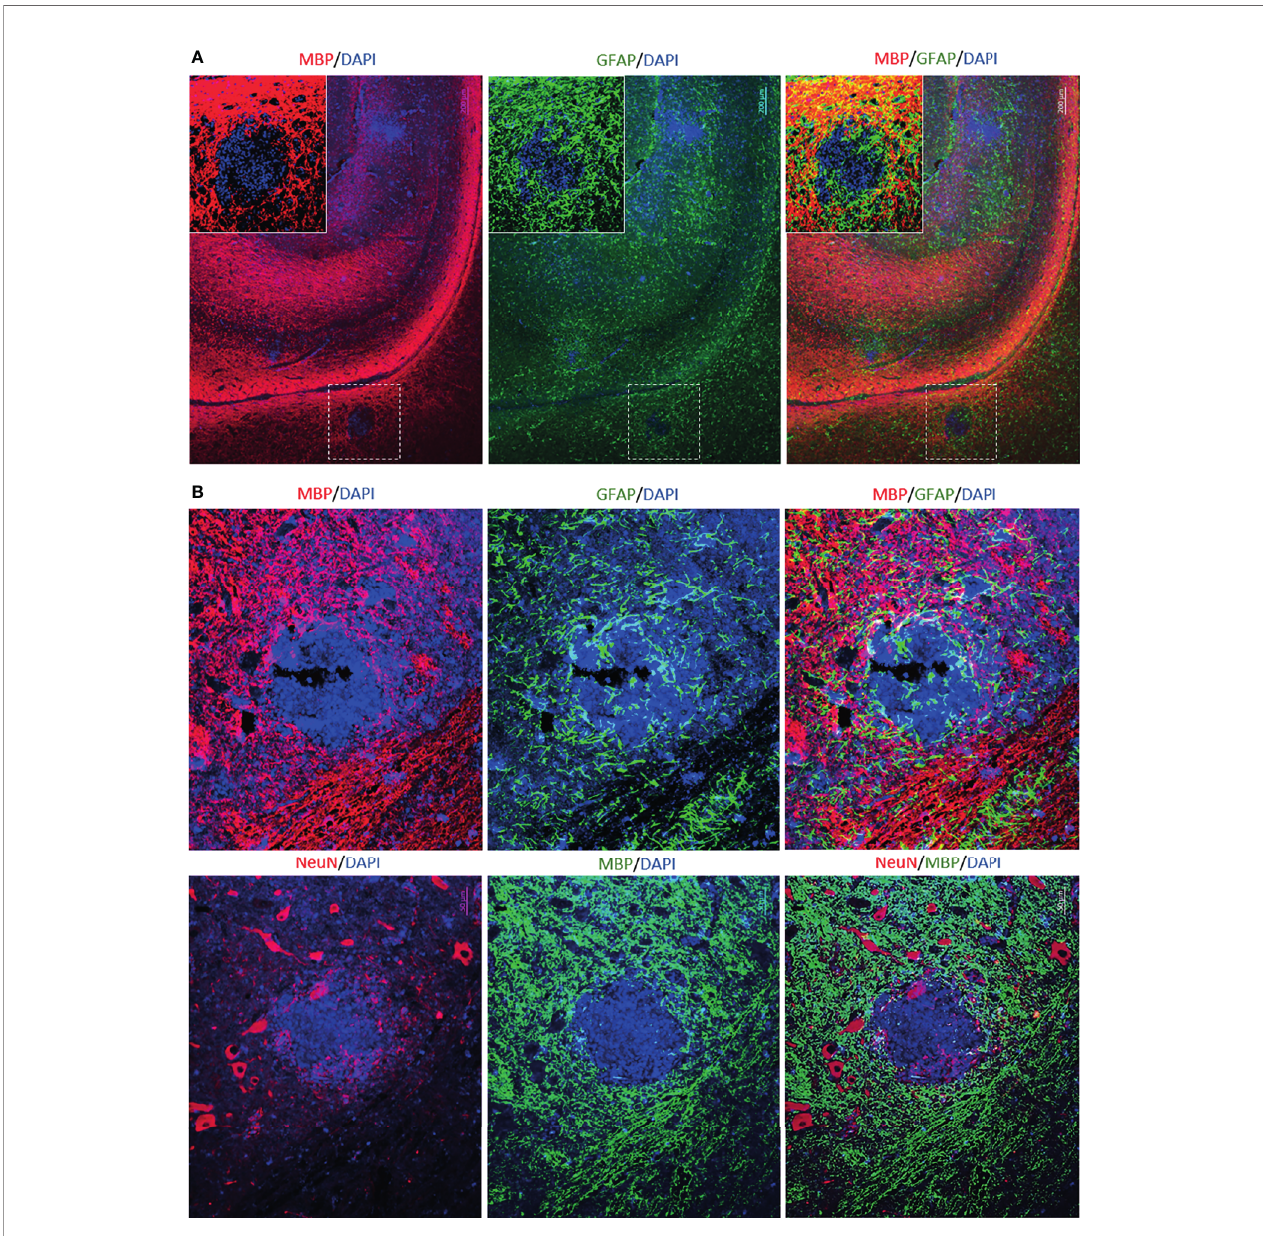
FIGURE 5 | Immuno fl uorescence double staining to assess demyelination in aggregates-positive case from EBV group. (A) Immunostaining for MPB and GFAP in the brain. Scale bar=200 m m (B) Immunostaining for MBP, GFAP and NeuN in the corresponding spinal cord. The aggregates were completely devoid of myelinated nerve fi bers. However, demyelination appeared to be restricted to the aggregates and it was not widespread. Scale bar=50 m